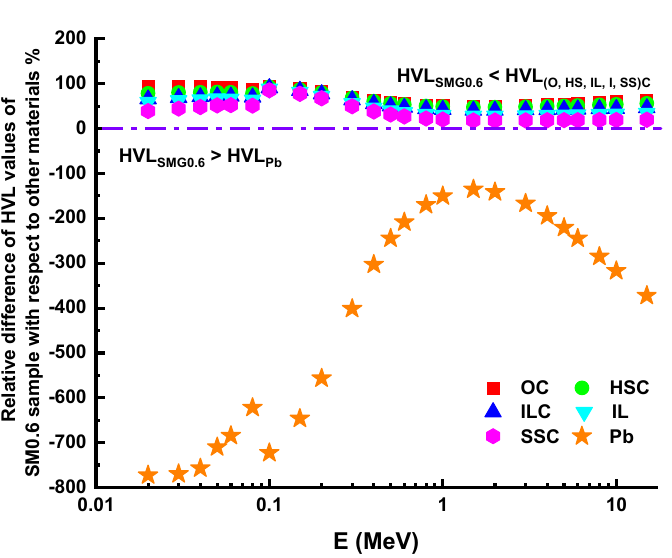
Figure 12. HVL results of glass samples as a function of glass composition and photon energy.